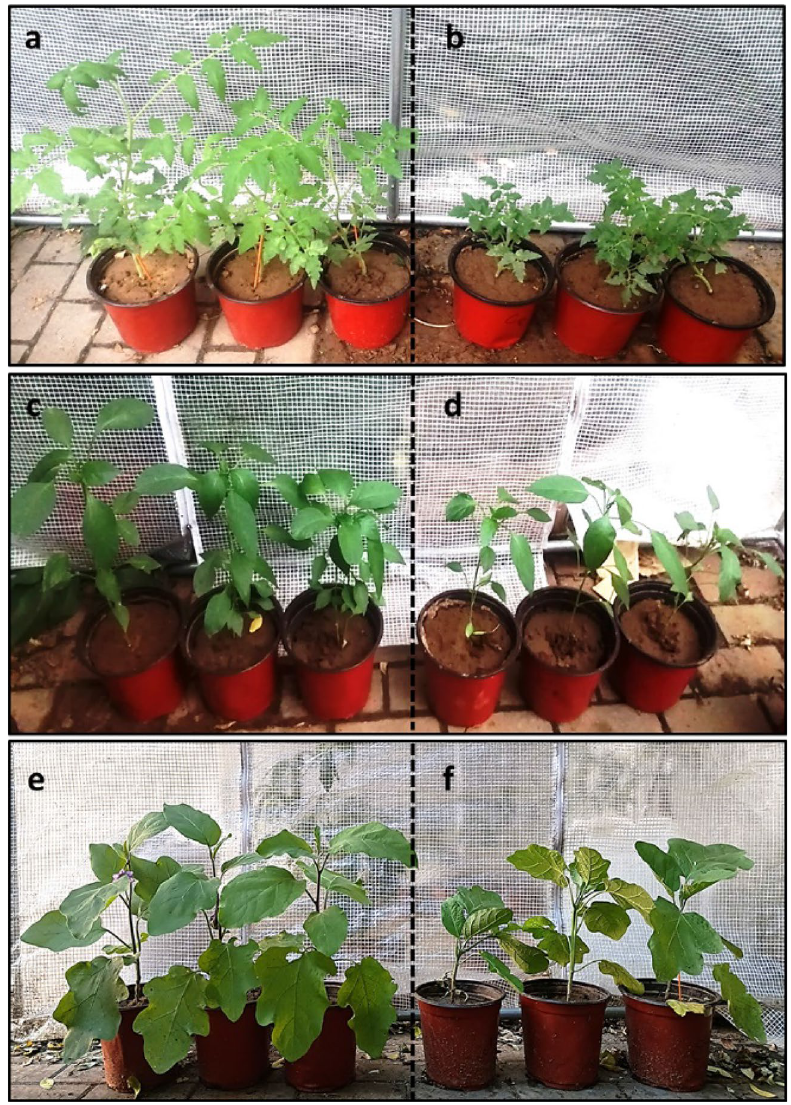
Figure 6. Analysis of the plant growth at the end of the 1st month of cultivation. ( a ) Tomato in soil with effluent, and its control without effluent ( b ); ( c ) Chilli grown in soil with effluent, and its control without effluent ( d ); and ( e ) brinjal grown in soil with effluent, and its corresponding control grown without effluent ( f ) (after 2